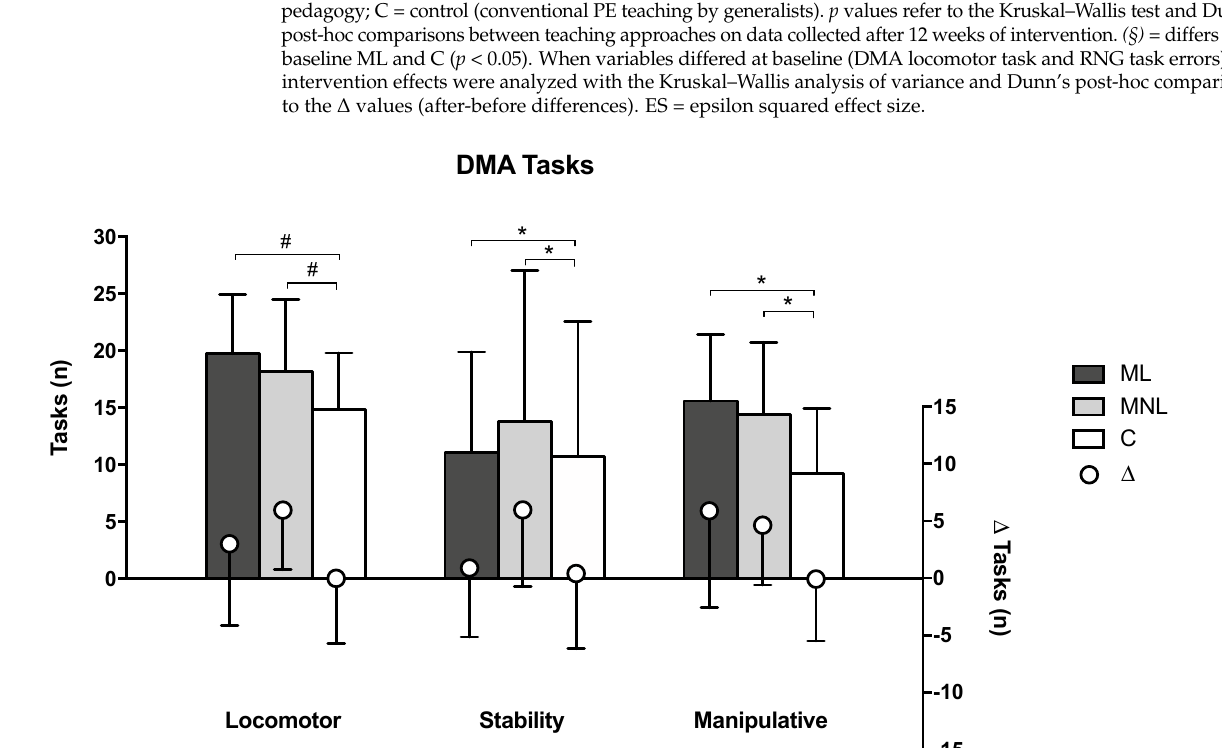
Figure 3. Effects of different teaching approaches on divergent movement ability (DMA) after 12 weeks of intervention. ML = multi-teaching approach emphasizing linear teaching; MNL = multi-teaching approach emphasizing nonlinear pedagogy; C = control (conventional PE teaching by generalists); ∆ = within-group post-intervention changes compared to baseline. Significant values are shown: # = p < 0.05 (analysis performed on ∆ after-before intervention because homogeneity at baseline was not met); * = p < 0.05 (analysis performed on post-intervention measures because baselines were homogeneous).